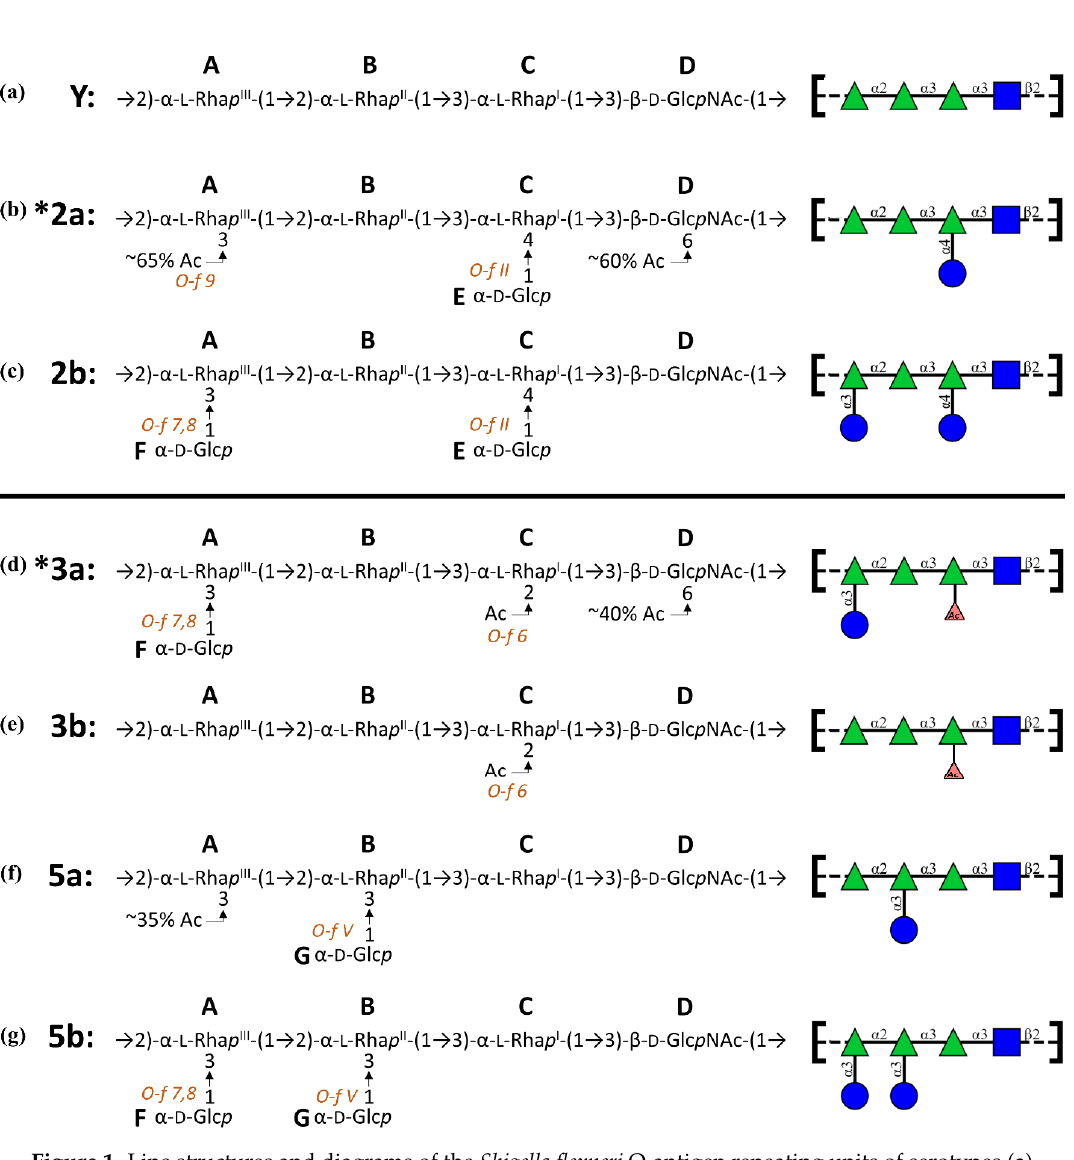
Figure 1. Line structures and diagrams of the Shigella flexneri O-antigen repeating units of serotypes ( a ) Y, ( b ) 2a, ( c ) 2b, ( d ) 3a, ( e ) 3b, ( f ) 5a, and ( g ) 5b. All serogroups share the serotype Y backbone and are distinguished by substitutions, which are labelled with the associated O-factors. Vaccine serotypes 2a and 3a are indicated with an asterisk. Schematic diagrams are depicted using the Symbol Nomenclature for Glycans (SNFG) symbol set [35] where green triangle—Rha, blue square—GlcNAc, blue circle—Glc, red triangle—O-acetylation.